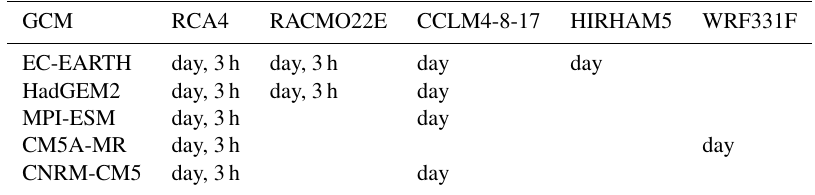
Table 1. EURO-CORDEX simulations analysed for this study and available temporal resolution of the data sets.